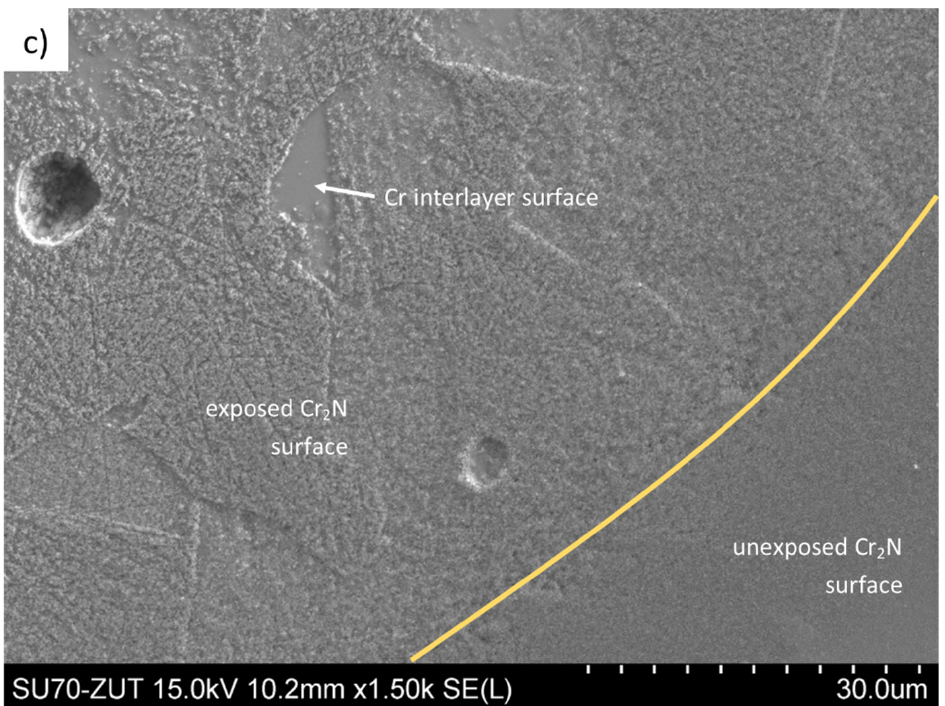
Figure 5. Top surface of coating: ( a ) S-phase (50 vol.% of N 2 )/Cr 2 N (substrate in as delivery state), ( b ) S-phase (50 vol.% of N 2 )/Cr 2 N (polished substrate) and ( c ) Cr/Cr 2 N (substrate in as delivery state) after potentiodynamic corrosion test, SEM.